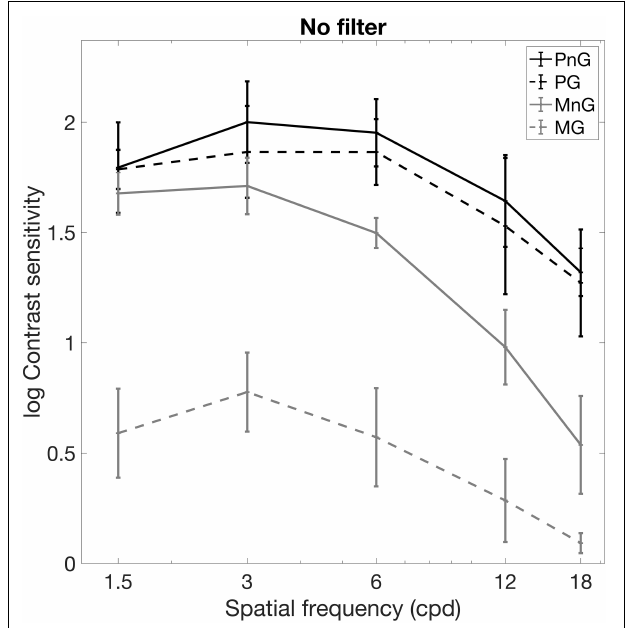
FIGURE 2 | Average photopic and mesopic contrast sensitivity measured without any filter under no glare and glare conditions. PnG: photopic luminance with no glare; PG: Photopic luminance with glare; MnG: Mesopic luminance with no glare; MG: Mesopic luminance with glare. cdp: cycles per